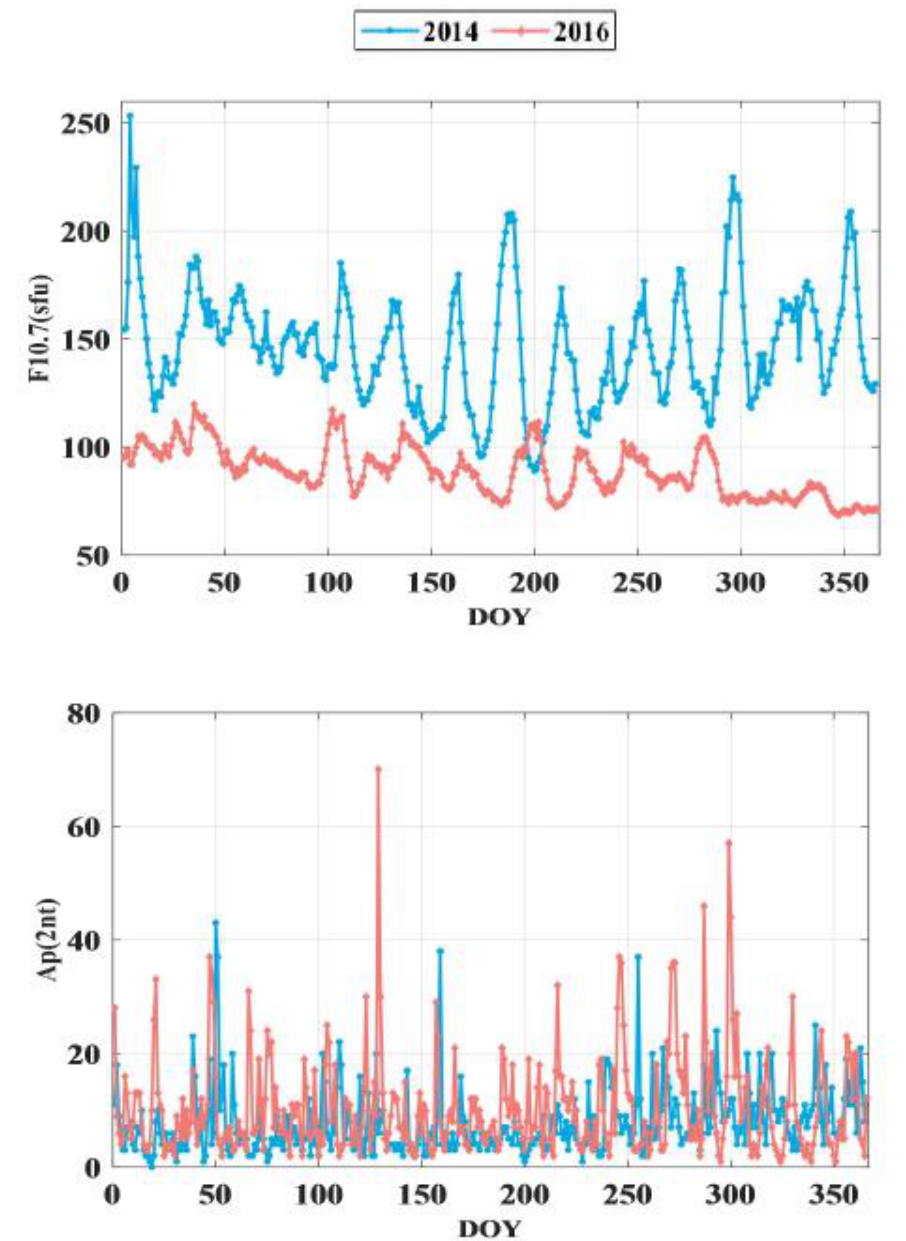
Figure 2. Variation of the daily F10.7 solar index ( top ) and Ap index ( below ) for the years 2014 and 2016.